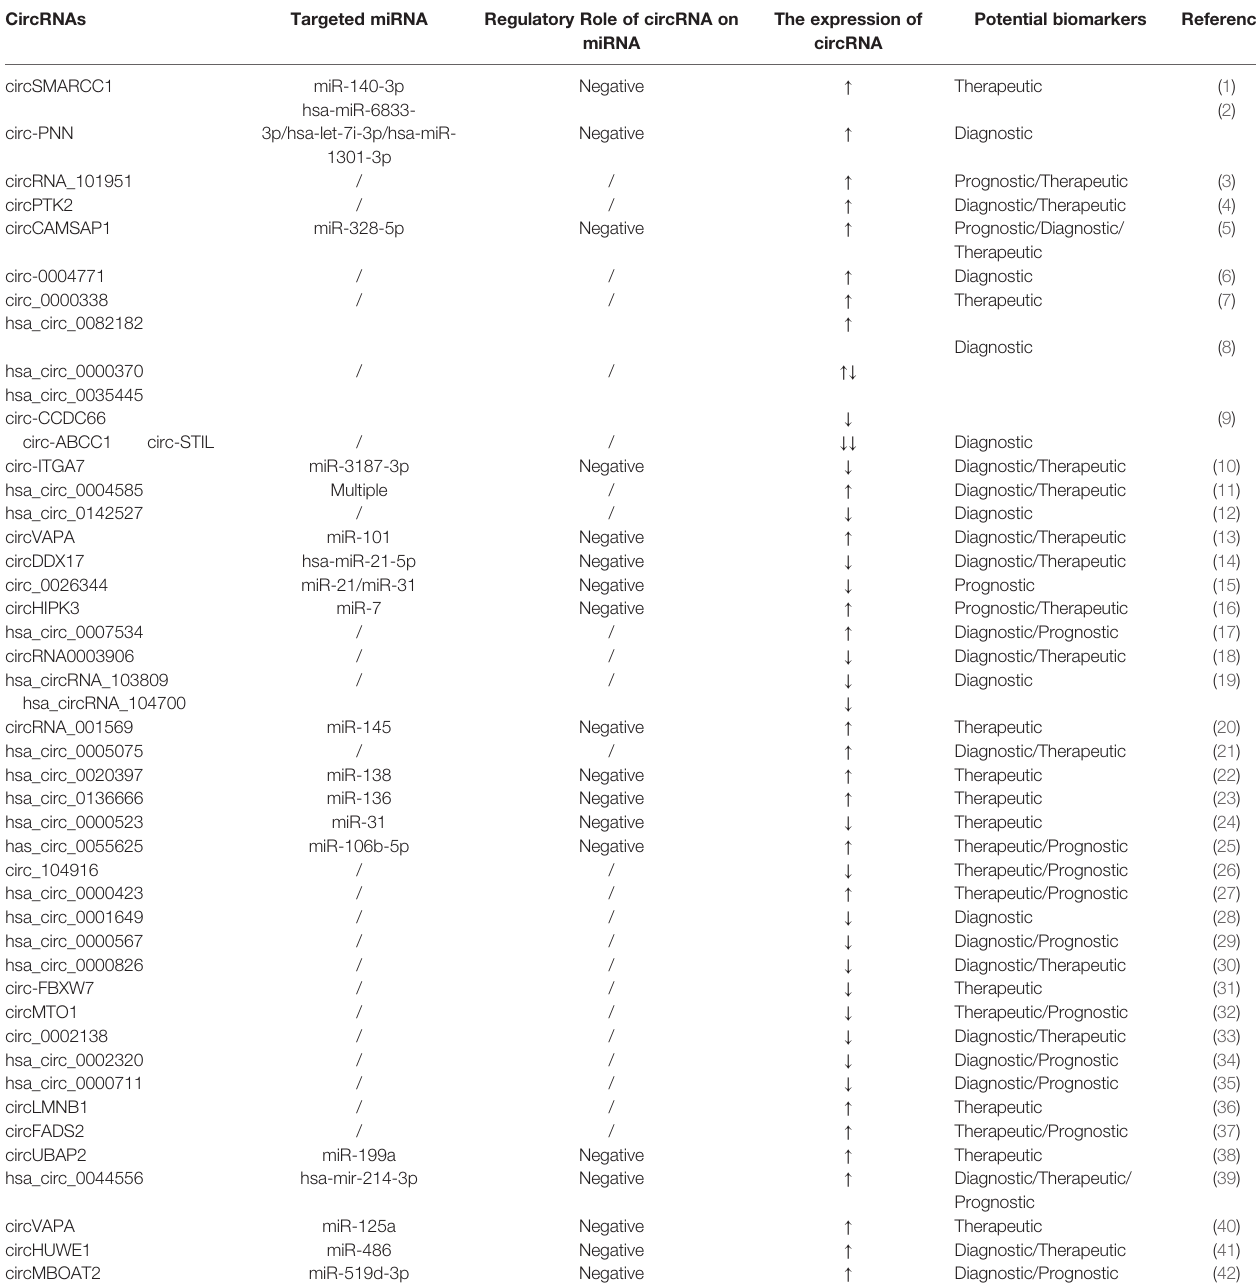
TABLE 3 | circRNAs as biomarkers for the diagnosis and prognosis of